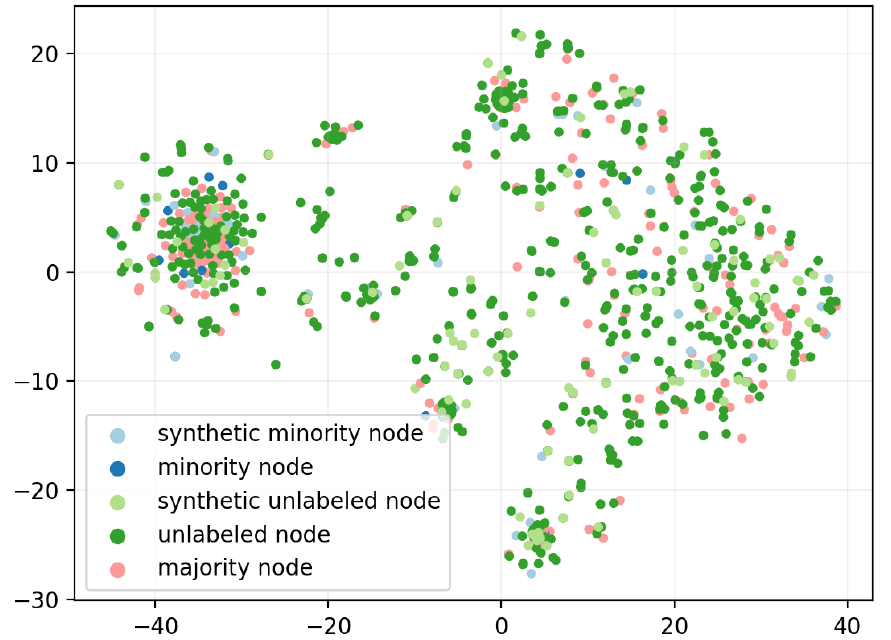
Figure 8. A t-SNE visualization of synthetic and real node features of the B LOG C ATALOG 3 dataset obtained from SORAG F . The node colors denote the labels.